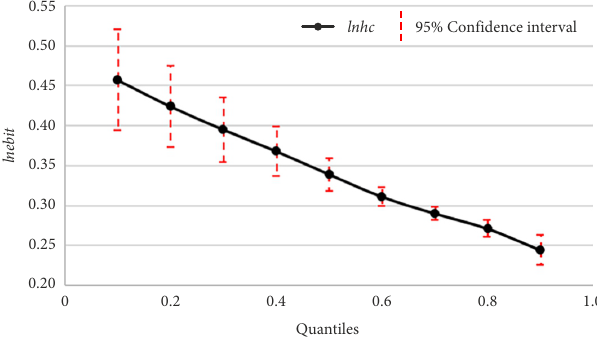
Figure A2. Effect of human resource training on economic performance